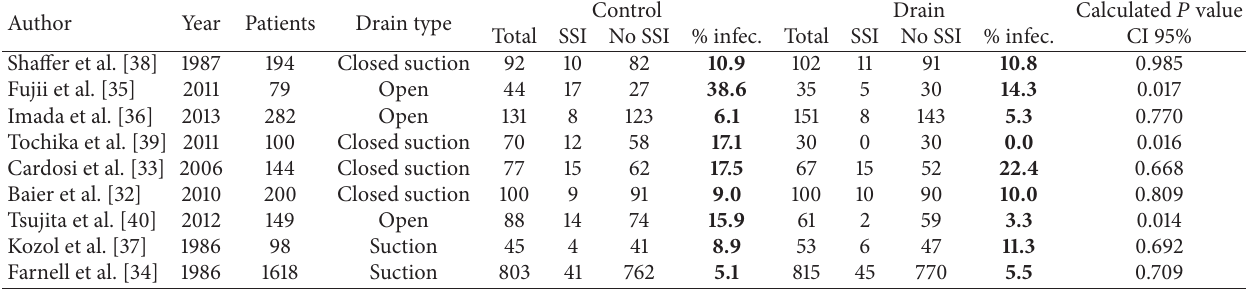
Table 1: Studies detailing the effects of subcutaneous wound drainage in laparotomies and detailing the outcome by infection rates. Author